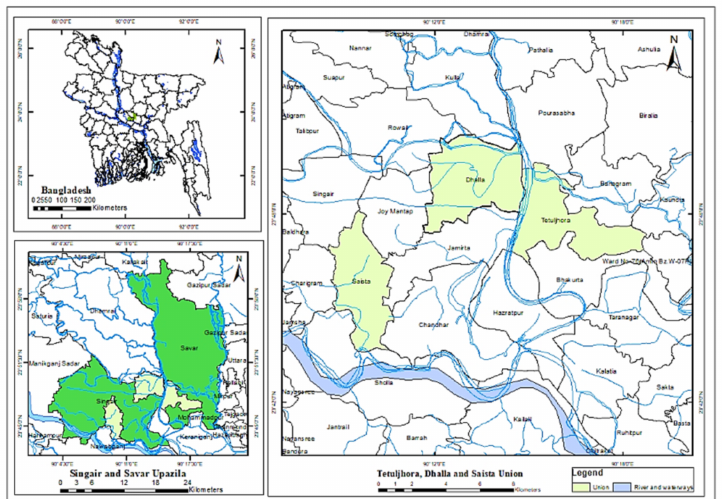
Figure 1. Location of the study area (the Dhalla and Saista unions in the Singair upazila and the Tetuljhora union in the Savar upazila,